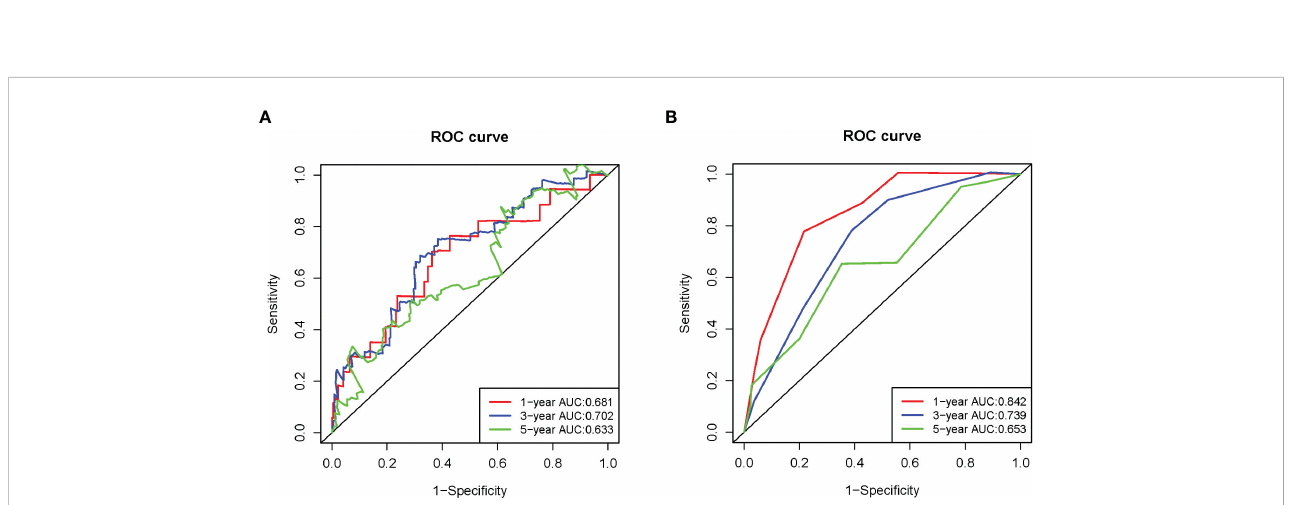
FIGURE 6 Time-independent ROC analysis in the LIRI-JP dataset. (A) Time-independent ROC analysis of risk scores for prediction the overall survival; (B) Time- independent ROC analysis of risk scores and TNM stage for prediction the overall